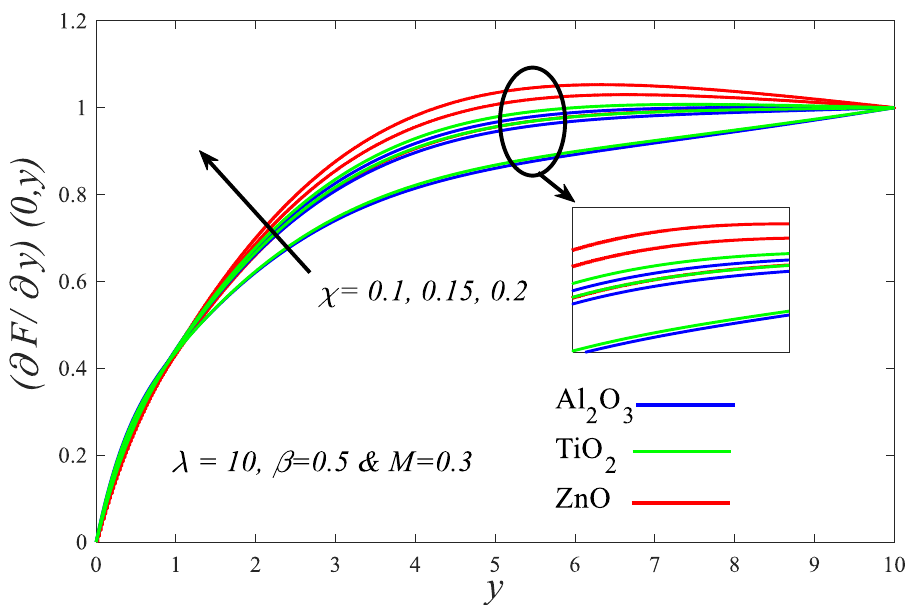
Figure 13. Impression of χ on ∂ F / ∂ y . The inset is a partial enlargement of the curves. Figures 14 and 15 depict the graphical findings of temperature and velocity versus the Casson parameter. The increase in the Casson parameter will inhibit temperature and velocity. The augmentation in the Casson parameter causes a decrease in the fluid viscosity, thereby the temperature decay. On the other hand, the increase in Casson factor values is followed by a decrease in the yield stress of the Casson fluid, as well as an increase in the plastic dynamic viscosity. This rise produces resistance in the fluid flow, which acts to limit the fluid velocity. See Figure 15 for details.